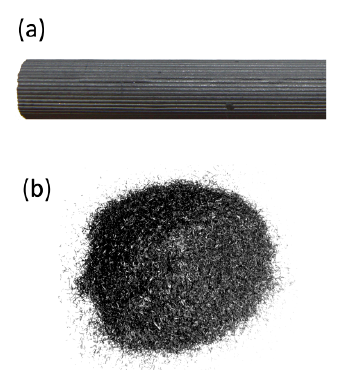
Figure 10. The example fuel samples used to supply the MH-DCFCs models: ( a ) graphite rod (diameter: 13 mm), ( b ) commercial biochar (particle size: 0.18–0.25 mm).